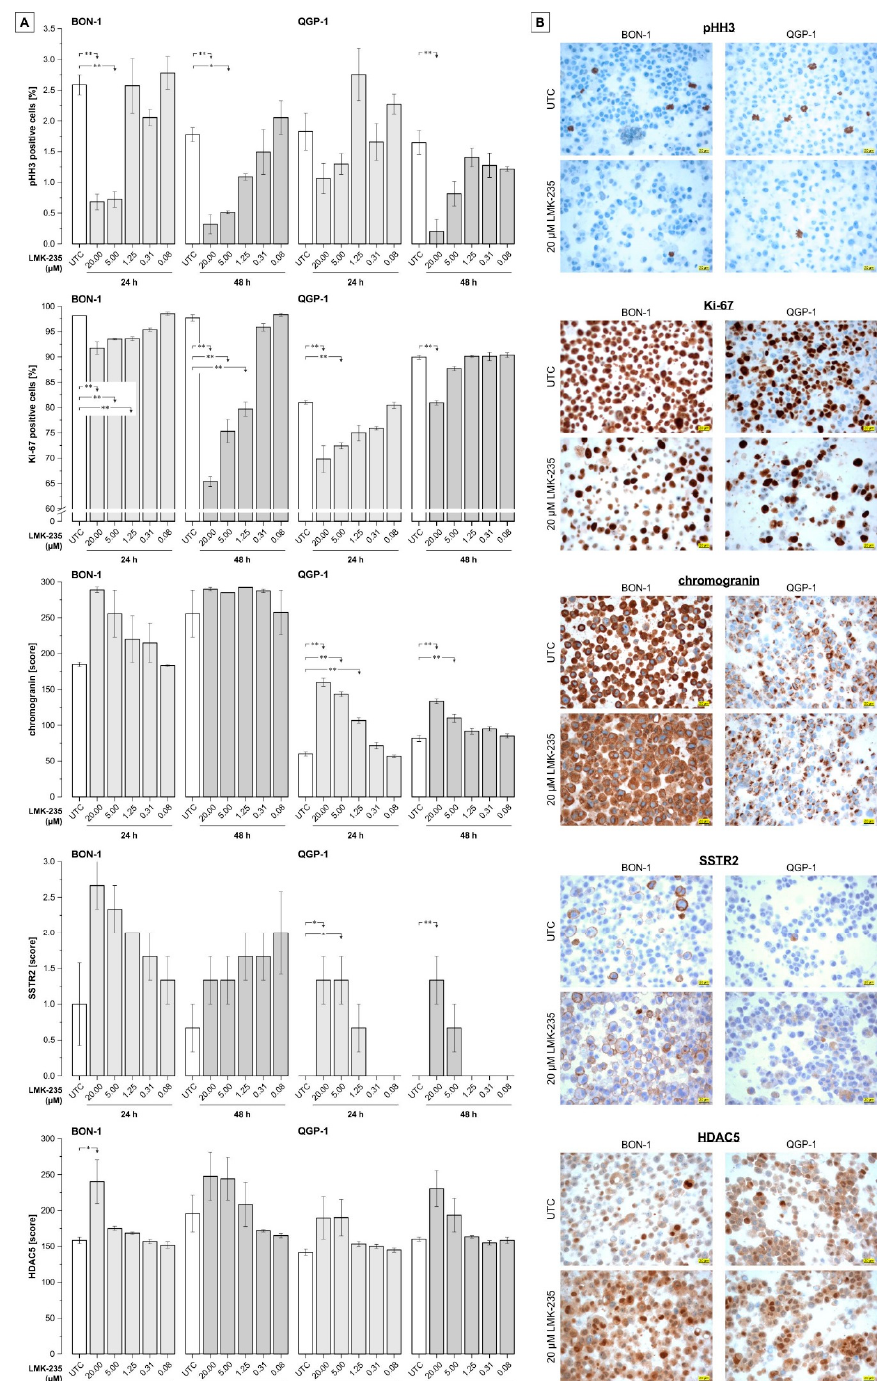
Figure 5. Immunocytochemistry on cell blocks of LMK-235-treated pNET cells. ( A ) Semiquantitative evaluation of immunostaining for phosphohistone H3 (pHH3) and Ki-67 (% positive cells), chromogranin (score, based on multiplication of intensity and extensity; 0–300), SSTR2 (score; 0–3), and histone deacetylase-5 (HDAC5 score; 0–300). Cells were treated with 0.08–20 µ M LMK-235 for 24 or 48 h and results represent mean values ± SEM of three independent images. Asterisks indicate p -values of <0.05 (one) or <0.01 (two) for comparison of treatments versus the corresponding untreated control (statistical results for group comparisons within treatments are not shown). ( B ). Representative images of the immunostainings for UTC and LMK-235-treated (20 µ M, 24 h) samples. Magnification 400 × for all images, scale bars indicates 20 µ m. Abbreviations: UTC = untreated